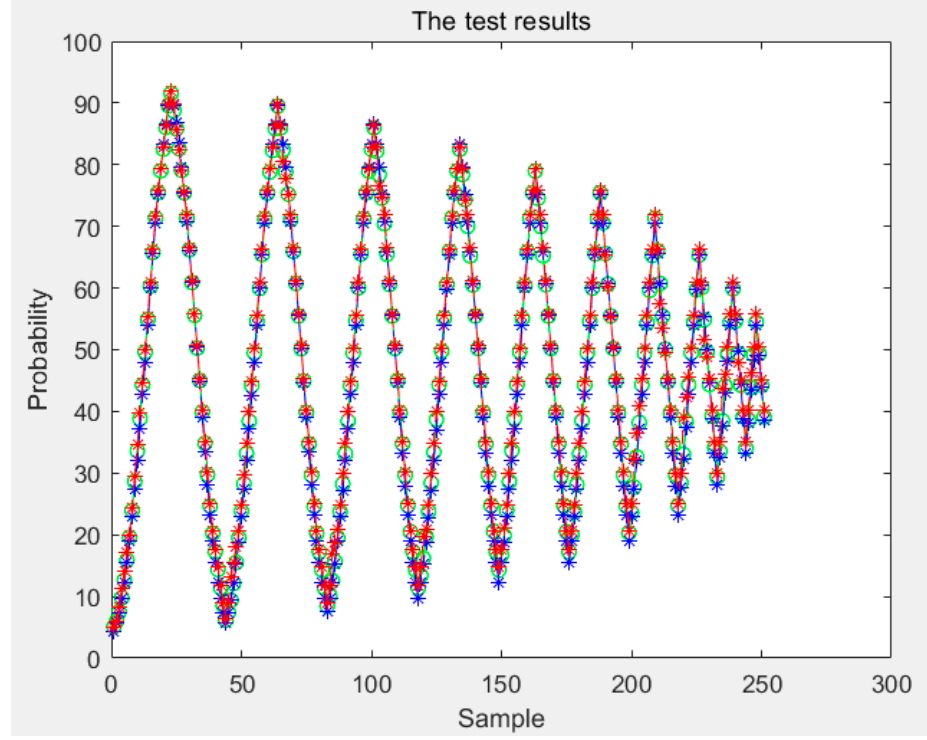
Figure 16. Test results of the first kind sensor for sparse data.